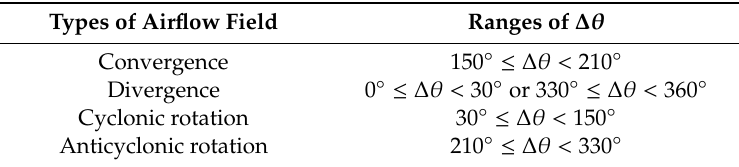
Table 1. Relationships between airflow field types and ∆ θ .